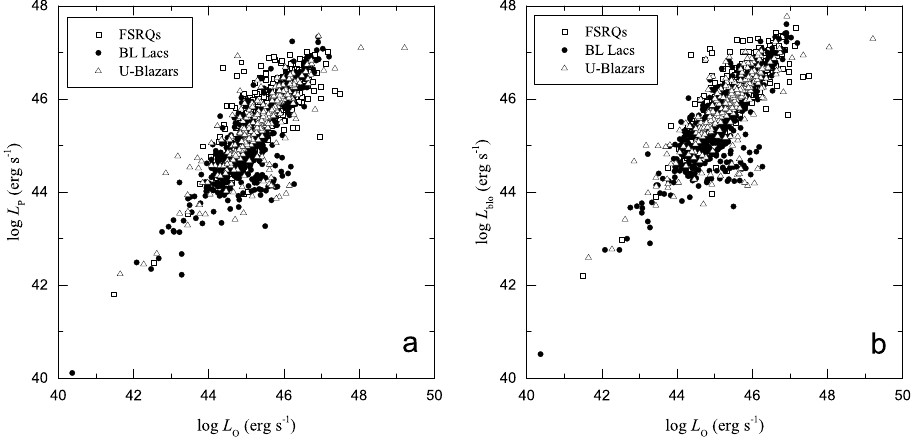
Figure 4. The correlations between optical luminosity (log L o ) and peak luminosity (log L p ) ( a ); and bolometric luminosity (log L bol ) ( b